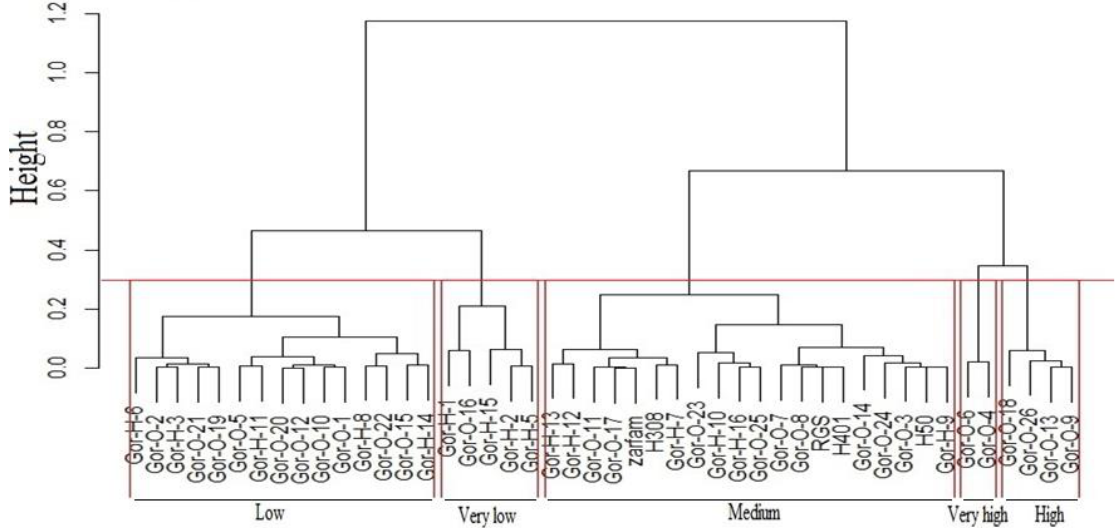
Fig. 6. Cluster analysis for the classification of 41 rapeseed lines and 5 cultivars based on assessing seed secondary dormancy by FRDT method.